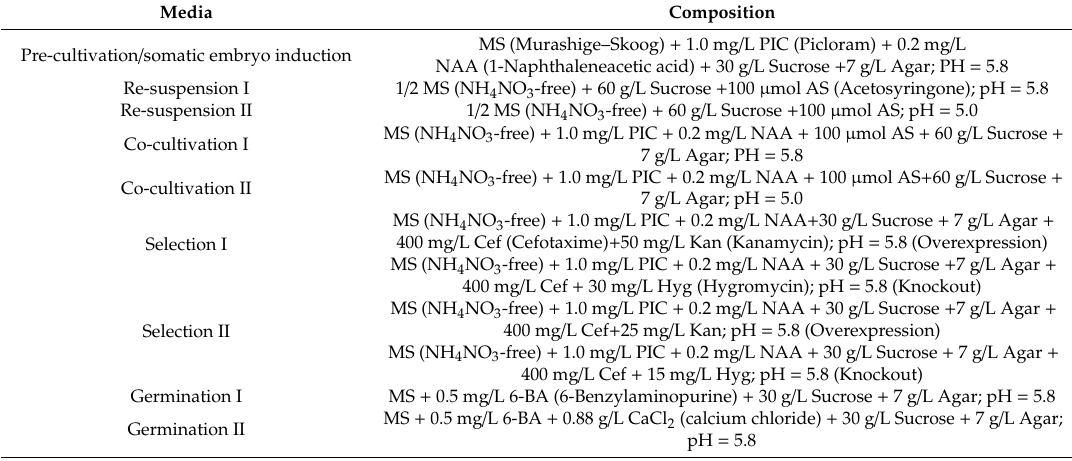
Table A1. Genetic transformation medium for Lilium pumilum DC.